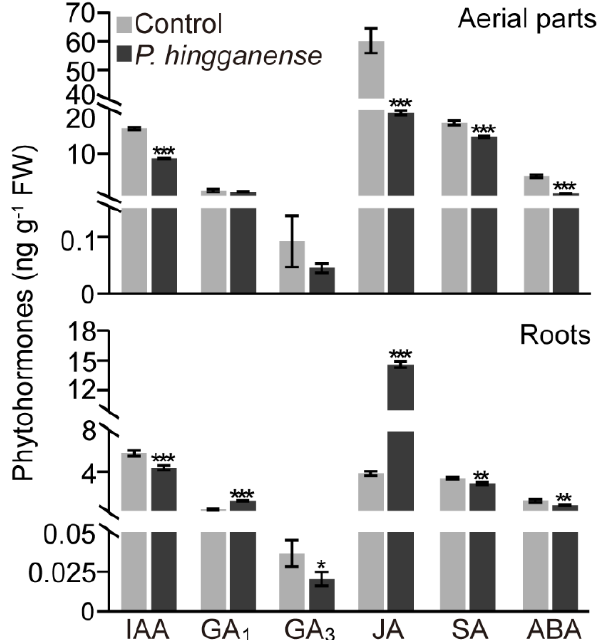
Figure 4. Impacts of P. hingganense on phytohormone levels in mung bean plants. Measurement of phytohormones from 21-day-old roots and aerial parts (stems and leaves). Values are means ± SD (n = 3). Asterisks indicate significant differences as evaluated by Student’s t -tests: * p < 0.05, ** p < 0.01, *** p < 0.001. IAA, indole-3-acetic acid; GA, gibberellin; JA, jasmonic acid; SA, salicylic acid; ABA, abscisic acid.